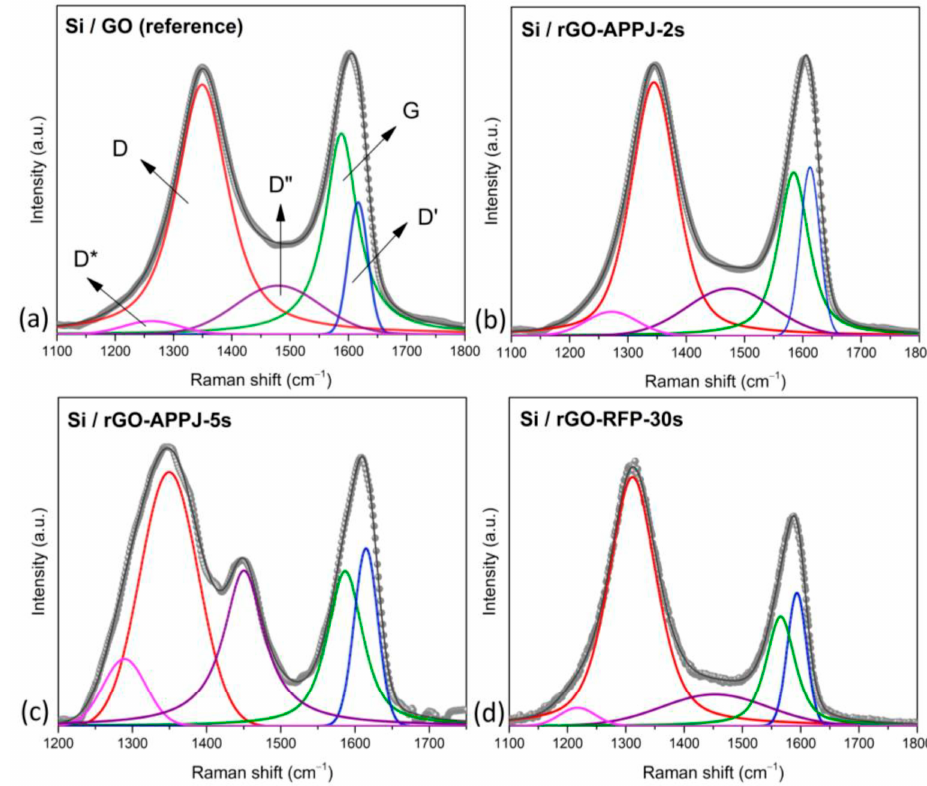
Figure 1. Fitted Raman spectra of GO ( a ), 2 s APPJ reduced GO ( b ), 5 s APPJ reduced GO ( c ), and 30 s RF plasma reduced GO ( d ) on Si substrates.